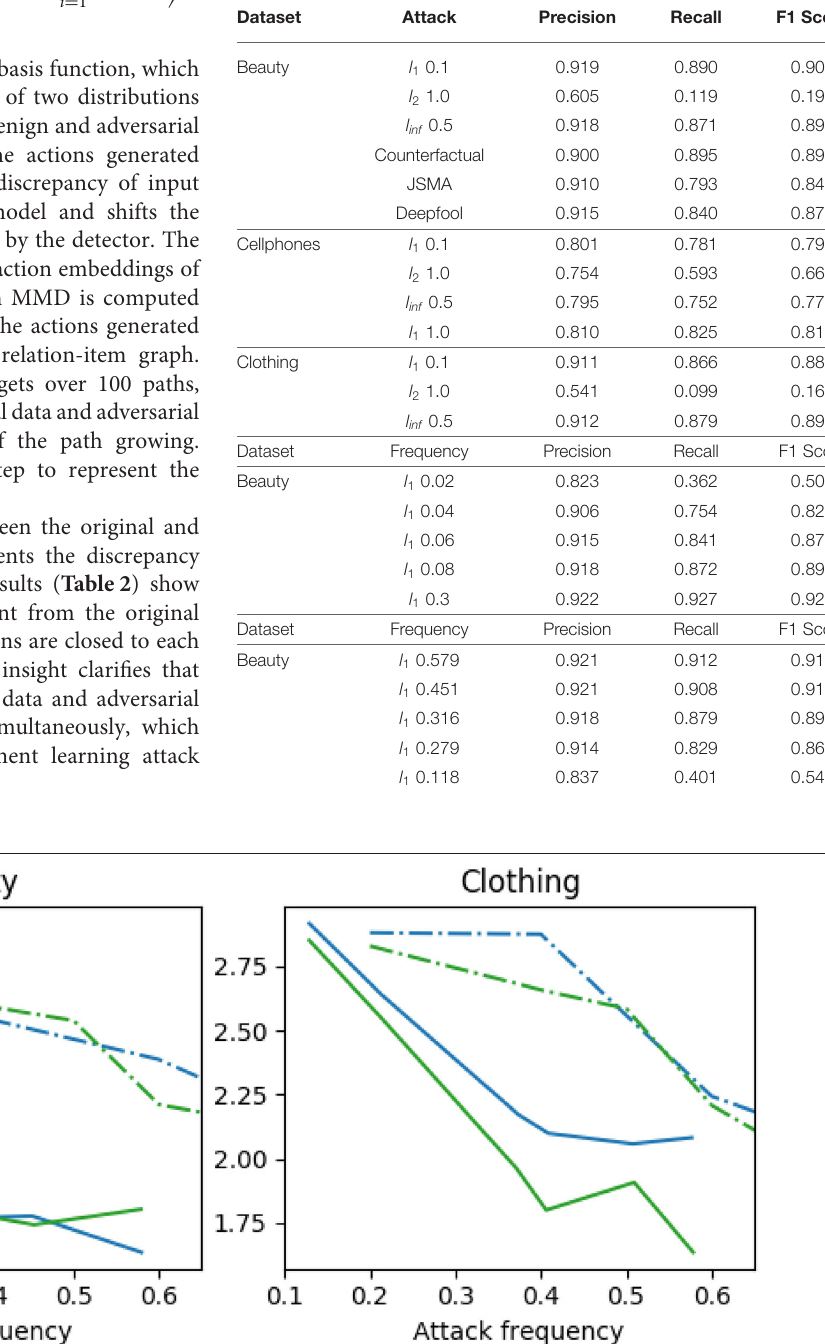
Frontiers in Big Data |